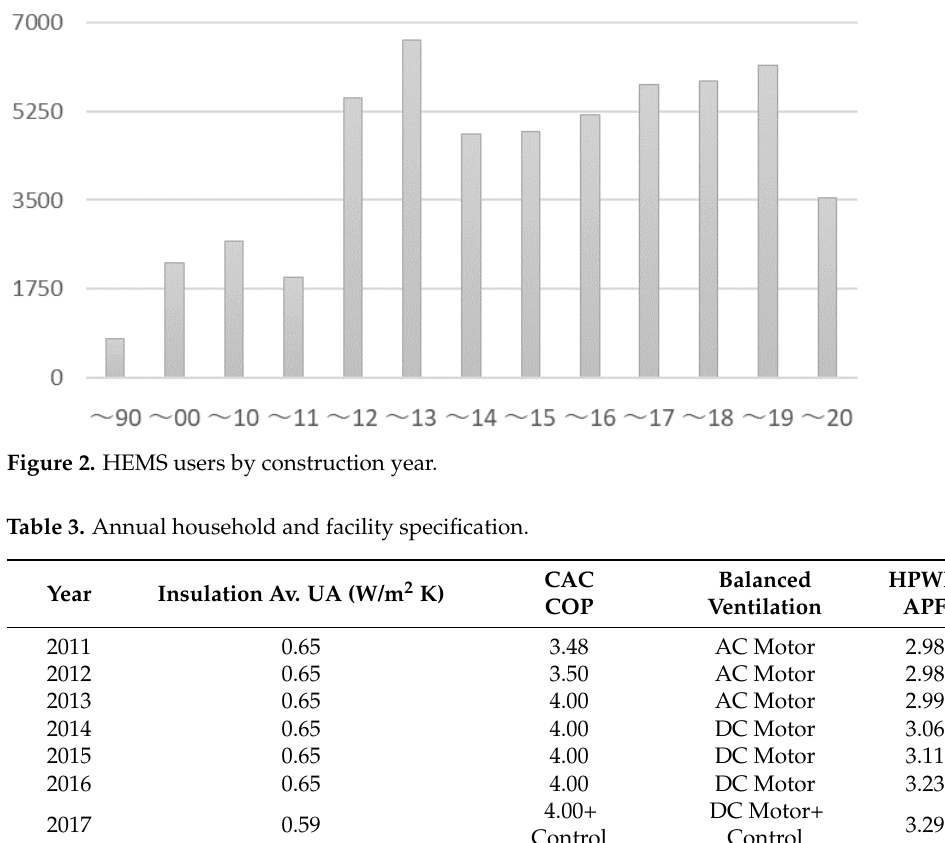
Table 2. HEMS users by energy conservation level zone.